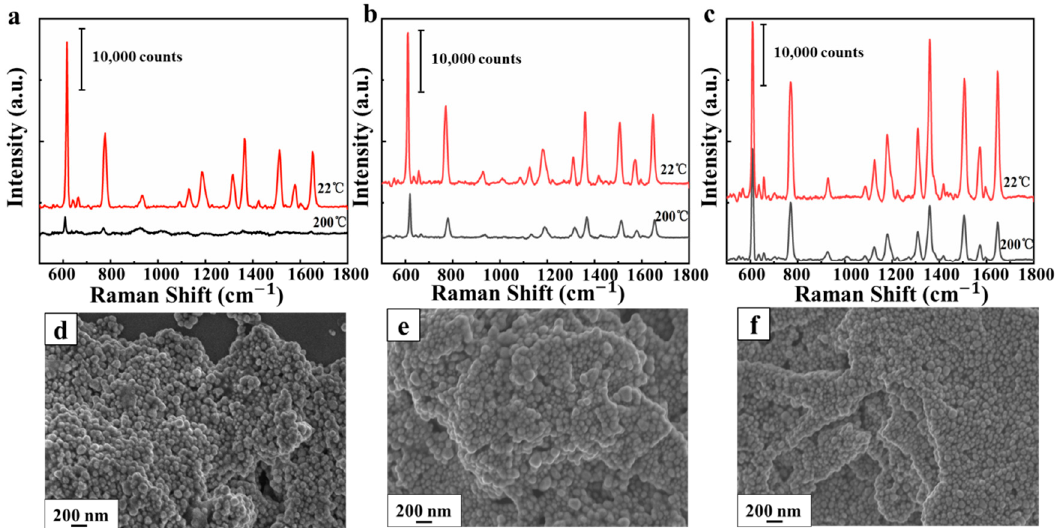
Figure 8. Raman spectra of R6G with concentration of 10 − 6 M on ( a ) four EM unit substrates, ( b ) four EM–CM unit substrates, and ( c ) four CM–EM unit substrates at room temperature and at 200 °C. SEM images of ( d ) four EM unit substrates, ( e ) four EM–CM unit substrates, and ( f ) four CM–EM unit substrates after heating at 200 °C.